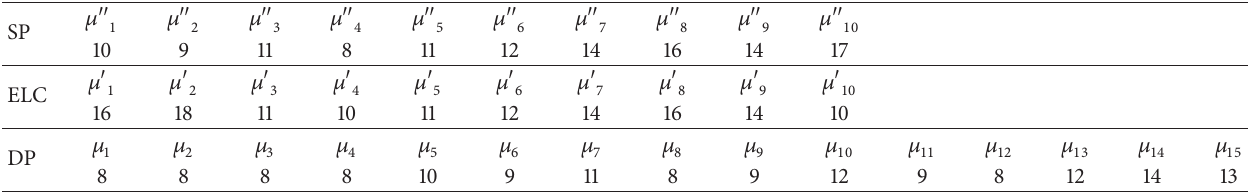
Table 2: The service rates specifications of different servers in the network.